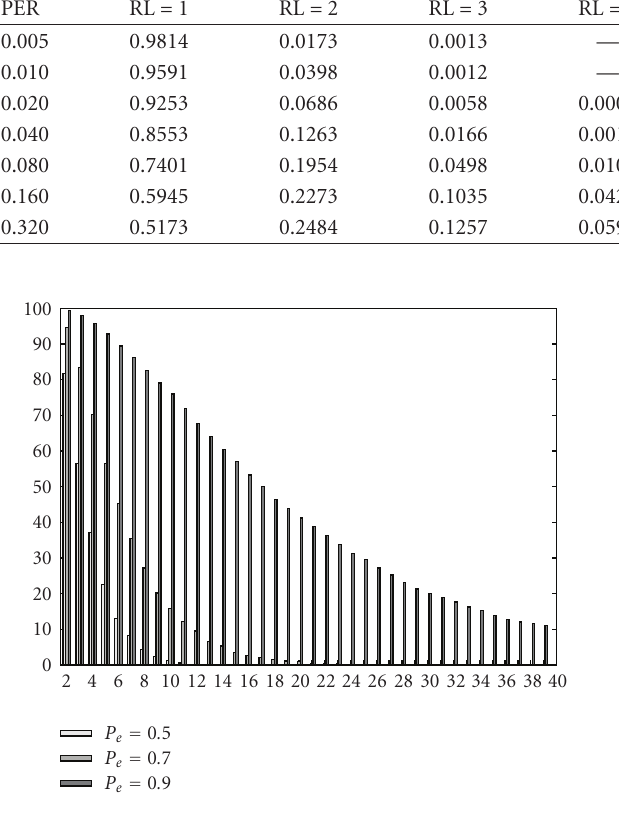
Figure 14: The average number of rounds to transmit a 60-second take under heavy